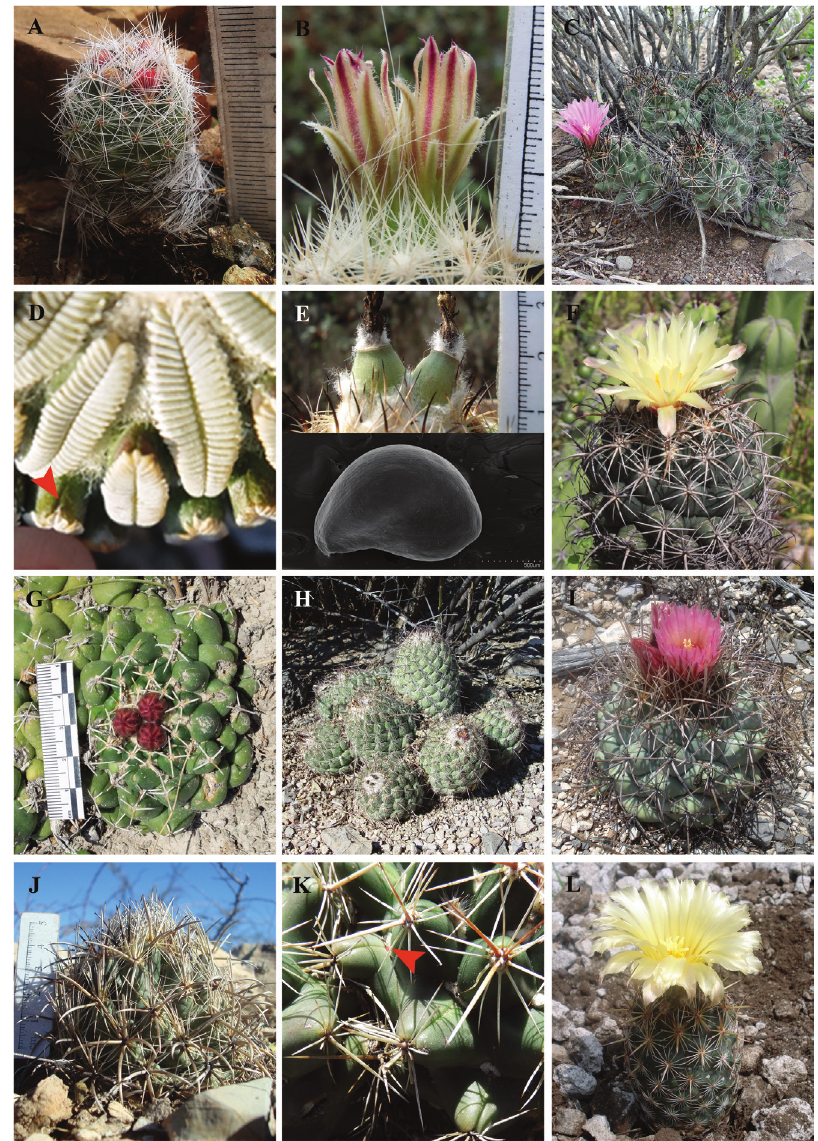
Figure 3. Representative species and morphology of Coryphantha and Escobaria A Escobaria dasyacantha bearing red fruits ( S. Arias 2090 , MEXU) B flower of Escobaria emskoetteriana (Quehl) Borg with fim- briate outer tepals ( D. Aquino 322 , MEXU) C Coryphantha macromeris bearing flowers with fimbriate outer tepals ( S. Arias 1788 , MEXU) D close-up of the furrow on the tubercles (arrow) in Pelecyphora aselliformis ( H. Sánchez-Mejorada 3616 , MEXU) E green fruits (top) and flat multicellular sculpture of the lateral side of the seed (bottom) in Coryphantha calipensis ( B. Vázquez 2555 , MEXU) F Coryphantha maiz-tablasensis ( D. Aquino 400 , MEXU) G Coryphantha cornifera ( SA 2212 , MEXU) H Coryphantha durangensis ( B. Vázquez 2625 , MEXU) I Coryphantha poselgeriana ( S. Arias 2109 , MEXU) J Coryphantha kracikii ( B. Vázquez 2618, MEXU) K glands at the axil (arrow) in Coryphantha ottonis ( D. Sánchez s.n., IBUG) L Coryphantha glanduligera ( S. Arias 2129 ,